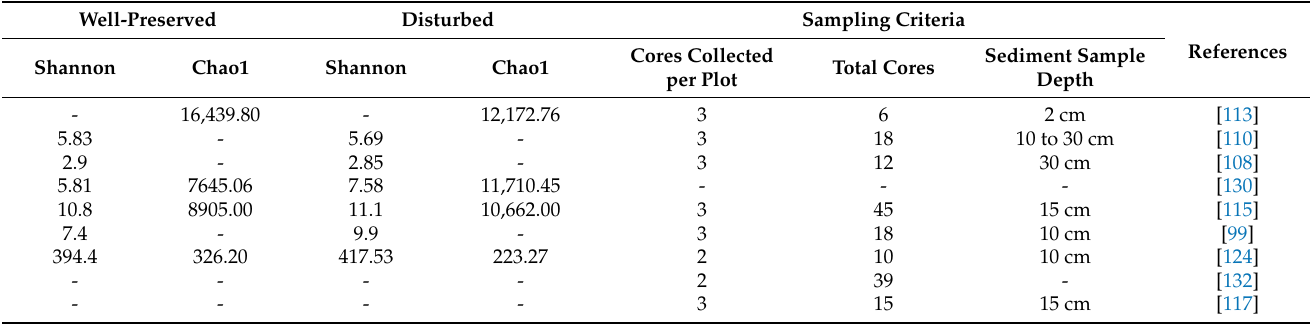
Table 3. Comparison of reported bacterial diversity indices and sampling criteria of disturbed and well-preserved mangrove